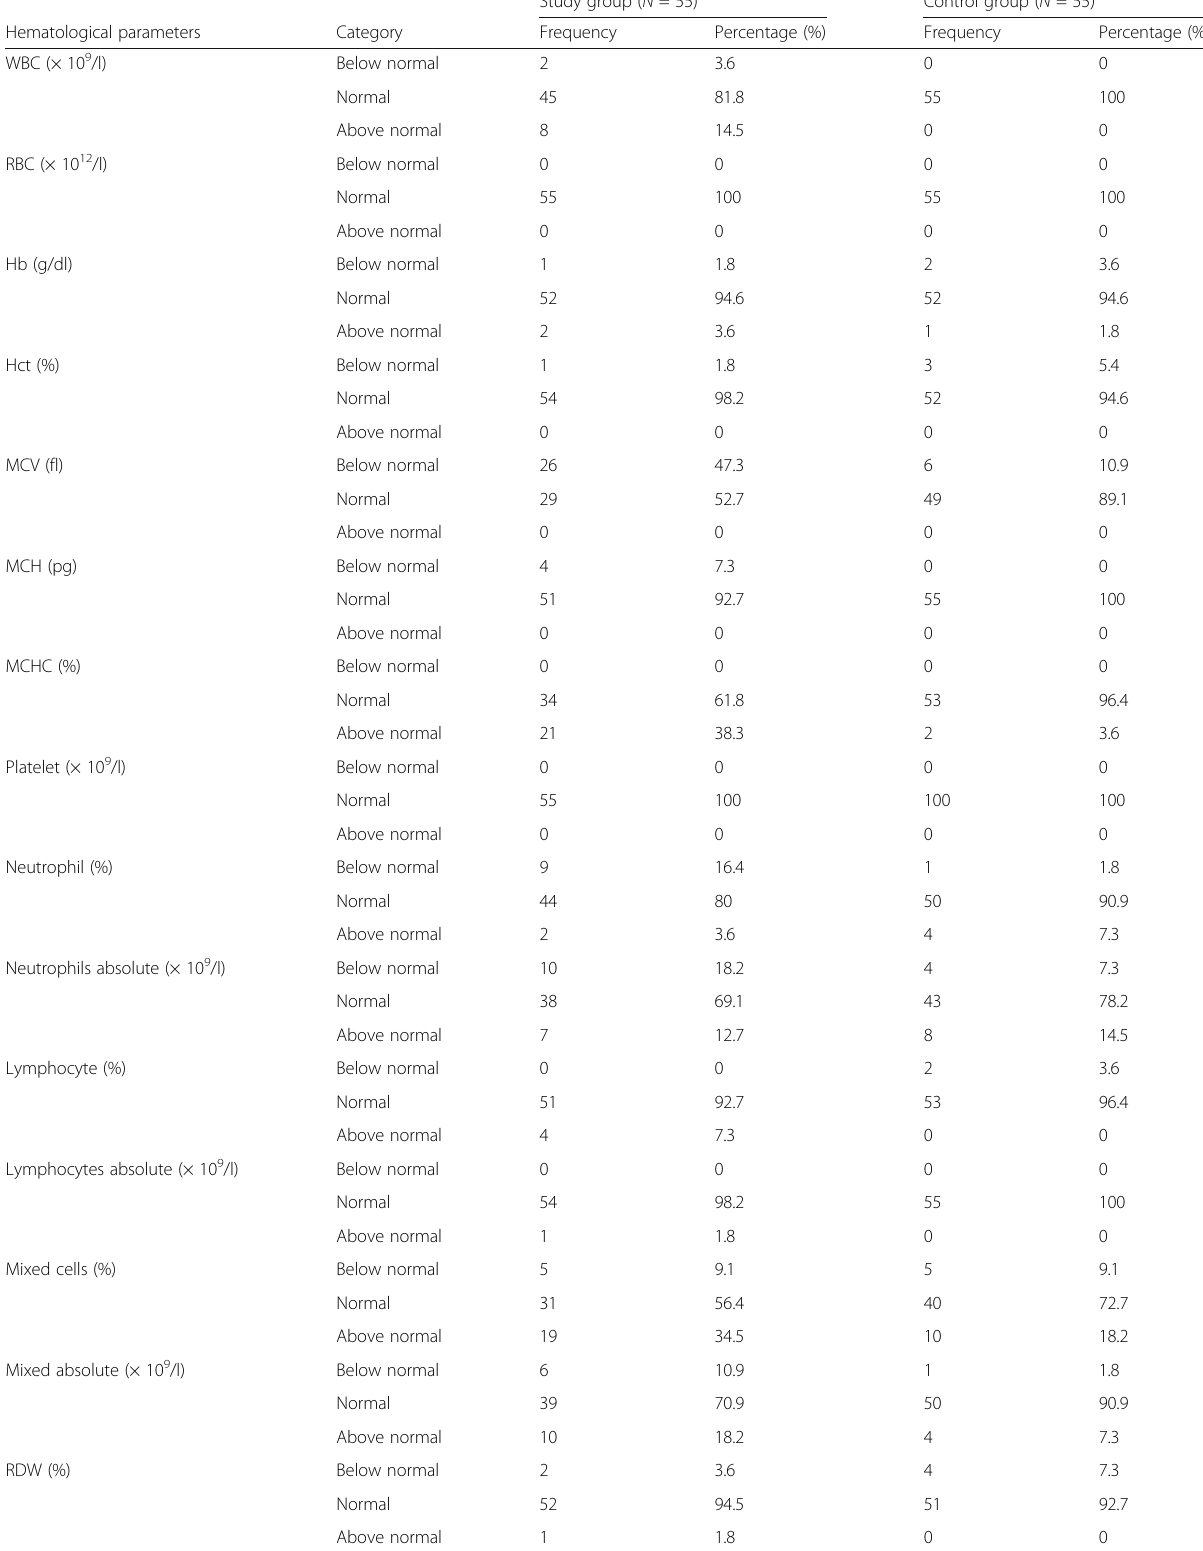
Table 2 Hematological parameters of study